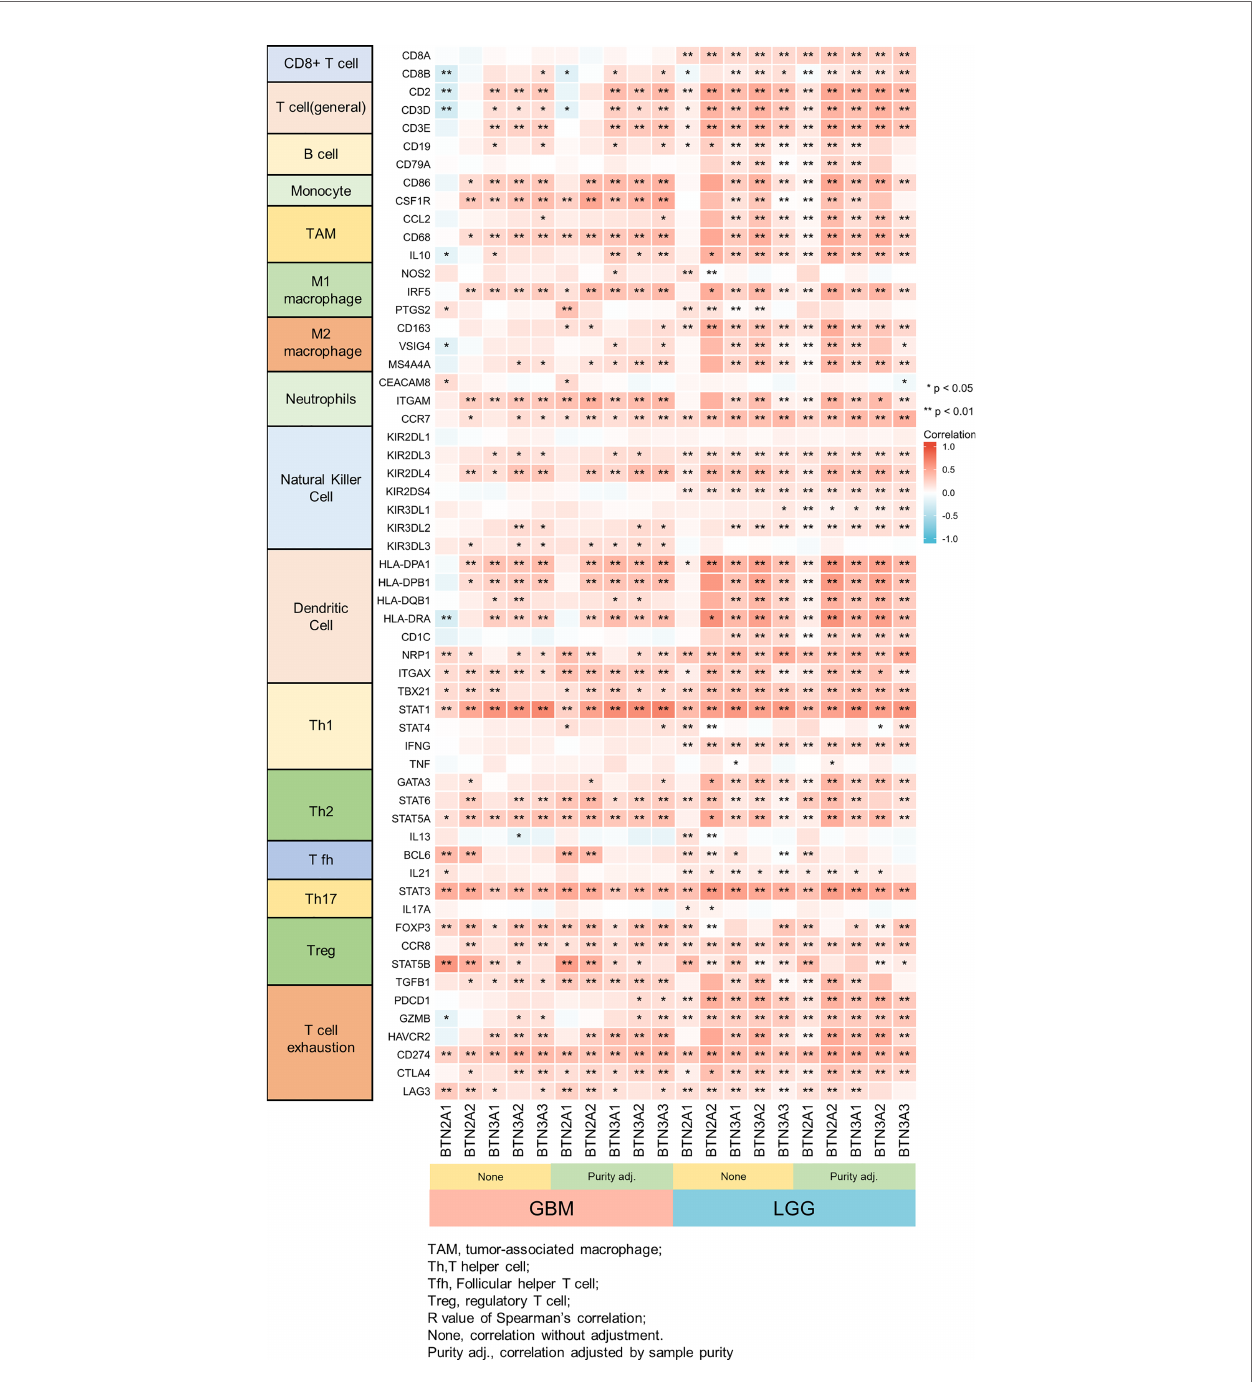
FIGURE 7 | Correlation heatmap between BTN2/3 subfamilies and markers of immune cells in pan-glioma by TIMER. *P < 0.05; **P <